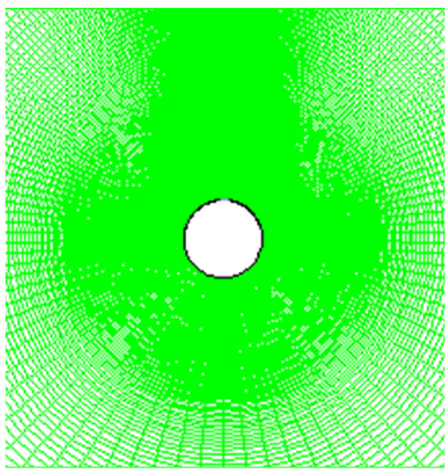
Figure 4. Computational grid.